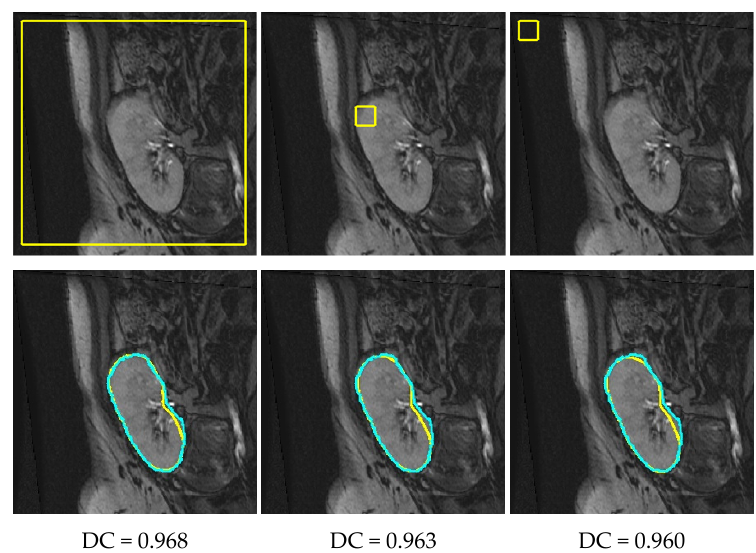
Figure 9. Example depicting how well the proposed approach performed with random initialized contours. Top row depicts a sample DCE-MRI scan with varying contour initializations in yellow, while the bottom row shows the output segmentations in yellow by the proposed approach. The ground-truth segmentations are overlaid in cyan, and the resultant DC value is given beneath each image.